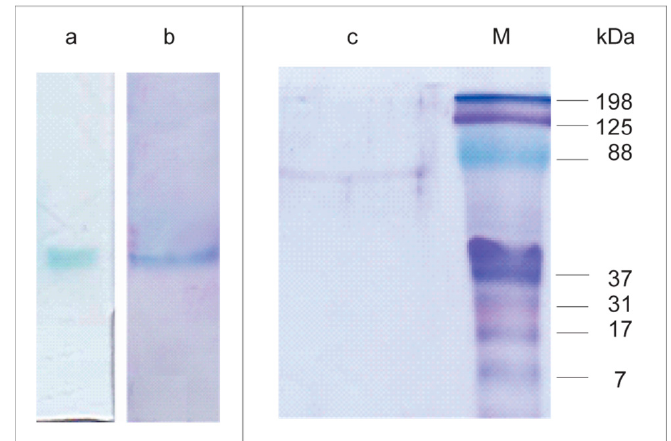
Figure 2. Analysis of the purified laccase by PAGE (lanes a and b ) and SDS-PAGE (lane c ). Lane a , laccase activity after PAGE, using 1 mmol·L − 1 2,2’-azino- bis (3-ethylbenzothiazoline-6-sulfonate) (ABTS) as substrate; lanes b and c , protein staining. Total protein loading was 25 μ g per lane. M, molecular mass markers.